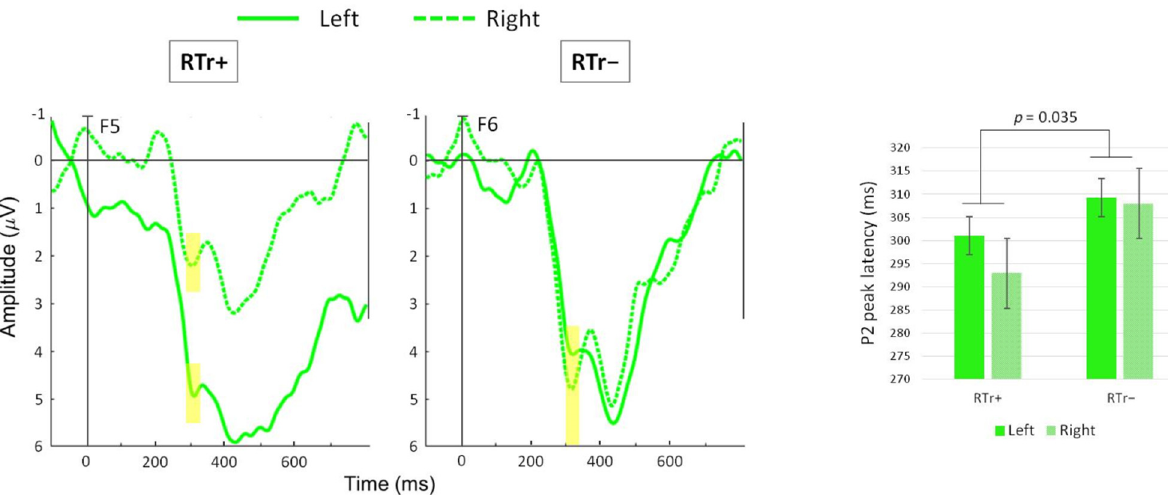
Figure 6. Grand average difference waveforms (DEVF minus STD) are shown, where the P2 peak is maximal. The waveform from channel F5 (representative of the left frontocentral region, solid line) is plotted against the waveform from channel F6 (representative of the right frontocentral region, dotted line) for RTr+ and RTr − infants. Highlighted yellow bars indicate the location of the maximum P2 peak. Plots were filtered using a 20 Hz low-pass filter for presentation purposes only. Negative voltage is plotted upward. On the right, bar graphs (error bars indicate SEM) show the mean P2 peak